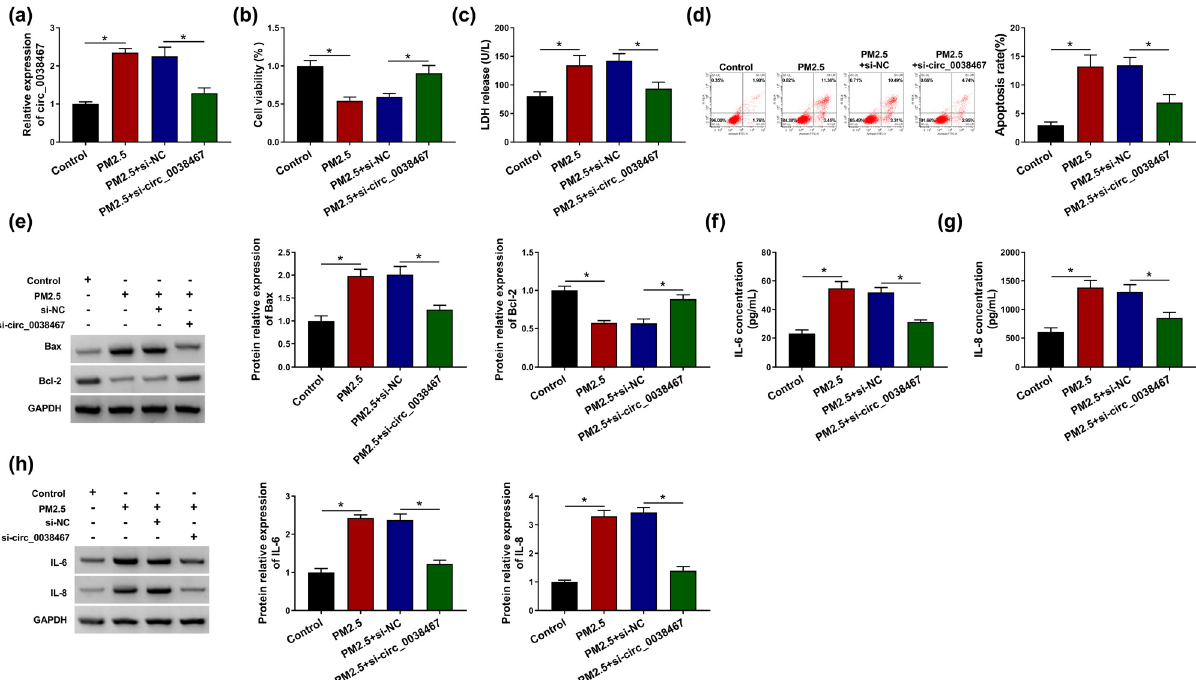
Figure 2: circ_0038467 knockdown reduced PM2.5 - induced cell death and in fl ammatory response in BEAS - 2B cells. BEAS - 2B cells were transfected with si - circ_0038467 or si - NC, then treated with 75 μ g/mL PM2.5 for 48 h. ( a ) RT - qPCR analysis of circ_0038467 expression in BEAS - 2B cells. ( b ) CCK - 8 assay of BEAS - 2B cell viability. ( c ) LDH assay of the release of LDH in BEAS - 2B cells. ( d ) Flow cytometry of BEAS - 2B cell apoptosis. ( e ) Western blot analysis of Bax and Bcl - 2 expression in BEAS - 2B cells. ( f – h ) Levels detection of IL - 6 and IL - 8 expression in BEAS - 2B cells using ELISA and western blot analyses. N = 3, * P <